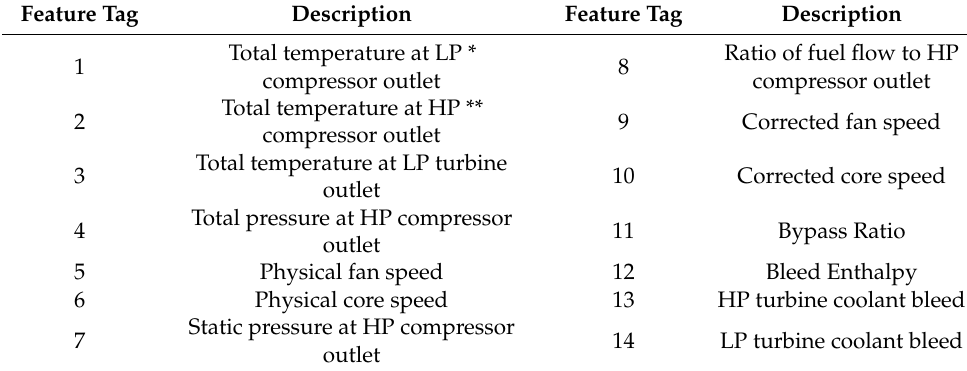
Table 5. C-MAPSS feature descriptions.